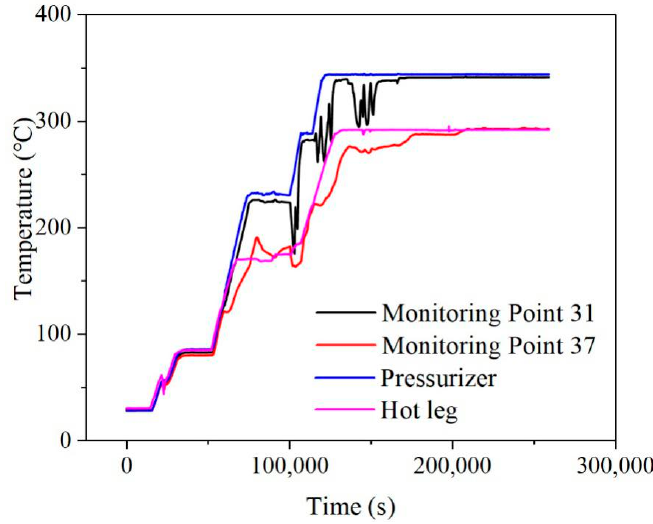
Figure 22. The temperature of the fluid from the pressurizer and hot leg.